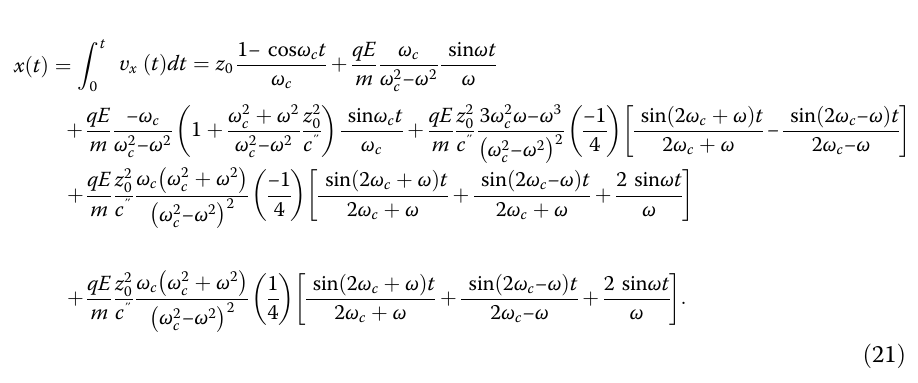
Every relativistic effect in Eq. (12) is acompanied